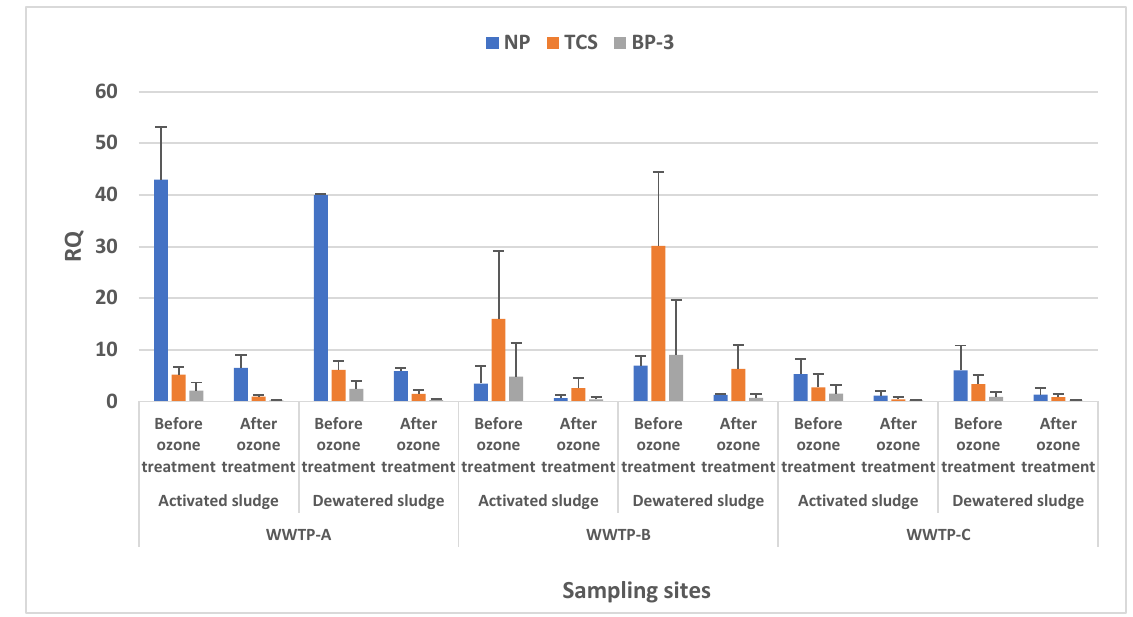
Figure 5. Calculated risk quotients of NP, TCS, and BP-3 of different sludges.